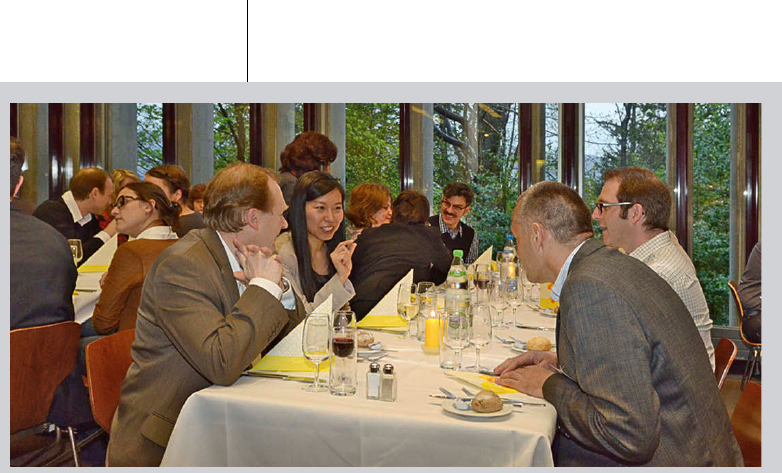
Figure 10: Conference